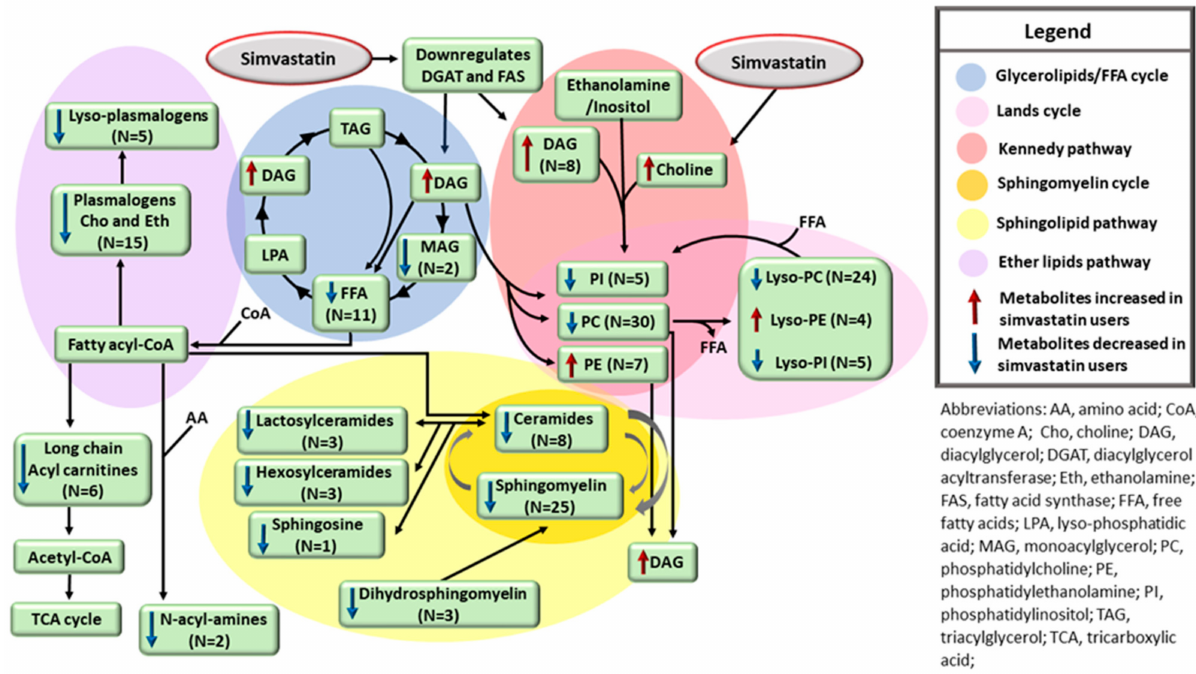
Figure 3. Effects of simvastatin treatment on lipid